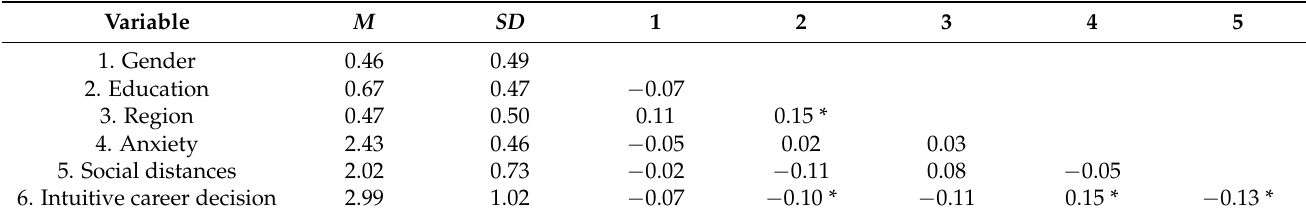
Table 3. The means, standard deviations, and correlations.